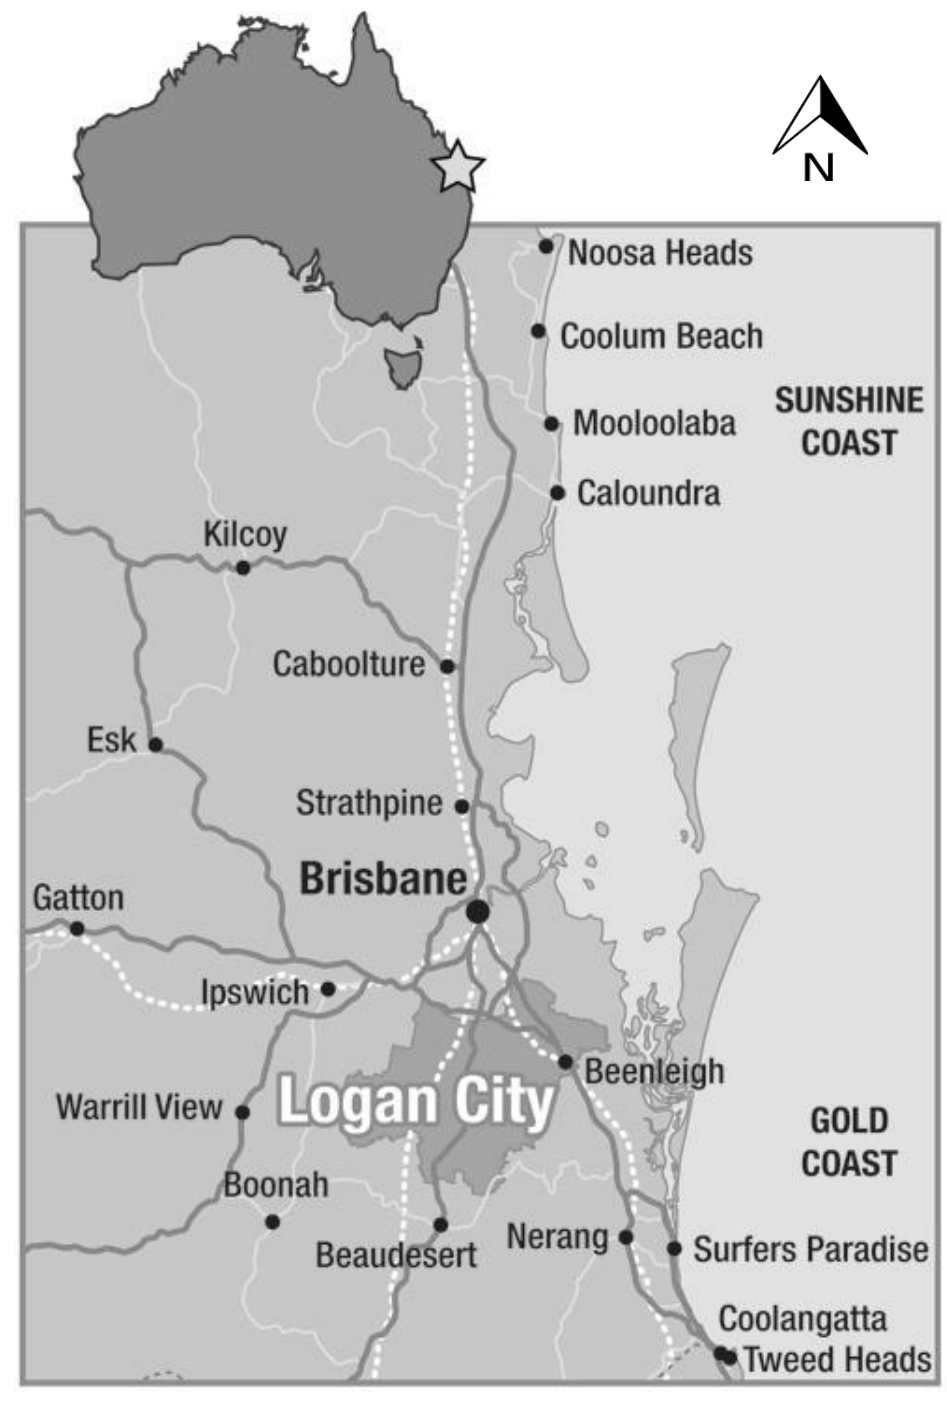
1. Location of Logan City in South-east Queensland, Australia